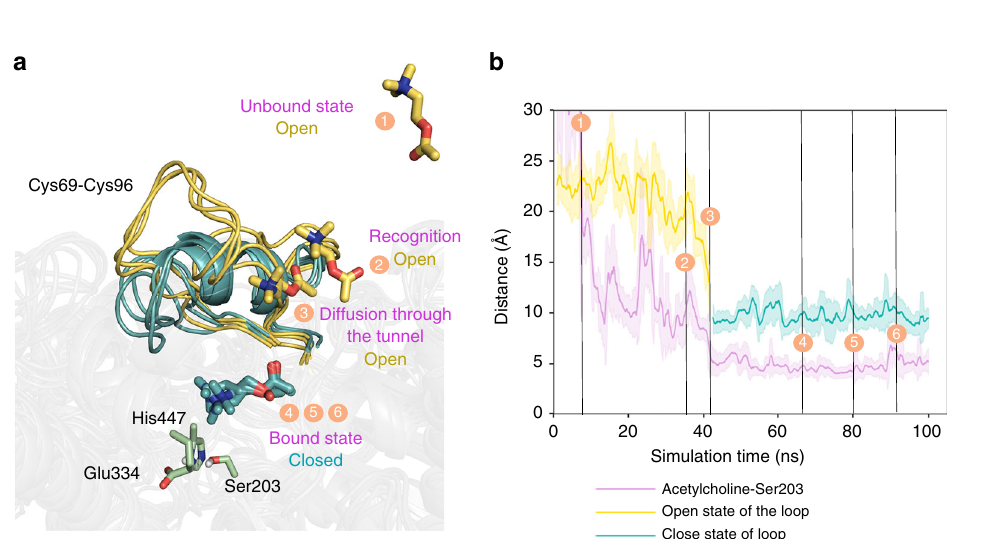
Fig. 4 Binding mechanism of acetylcholine substrate on AChE. a Overlay of representative conformations along the binding pathway obtained from aMD simulations. Open conformations of the loop (de fi ned by Cys69 – Cys96 residues) and substrate conformations located outside the active site are represented in dark yellow (events 1 – 3), while closed conformations of the loop and substrate bound to the active site are shown in teal (events 4 – 6). Active site residues are shown in green. b Representation of the loop distance (in Å) between Pro78 – Ser203 along the aMD simulation. Dark yellow solid line corresponds to open conformations of the loop, while teal color is used to highlight closed conformations. The open-to-closed transition of the loop is correlated to substrate binding, as shown by the purple solid line representing the distance (in Å) between the nitrogen atom of acetylcholine substrate and the oxygen atom of the side-chain of catalytic Ser203. Results are shown as the mean ± standard deviation